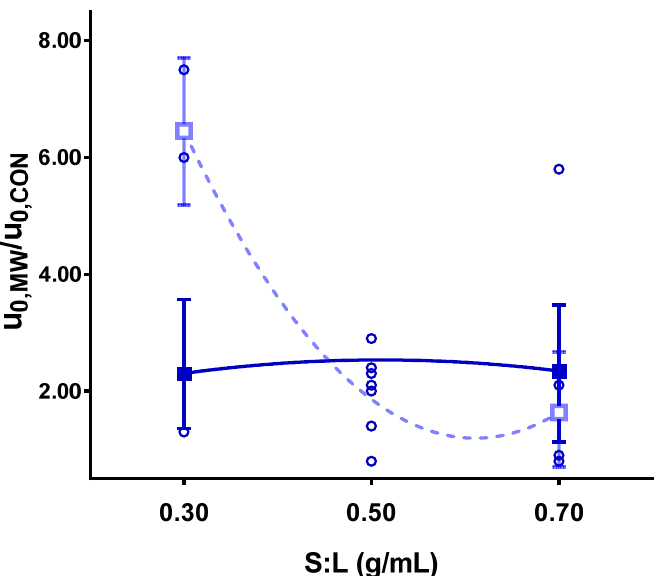
Figure 5. Coupled effect of S:L ratio and pretreatment temperature on the polyphenols initial extraction rate at 60 °C ( ■ ) and 120 °C ( □ ).